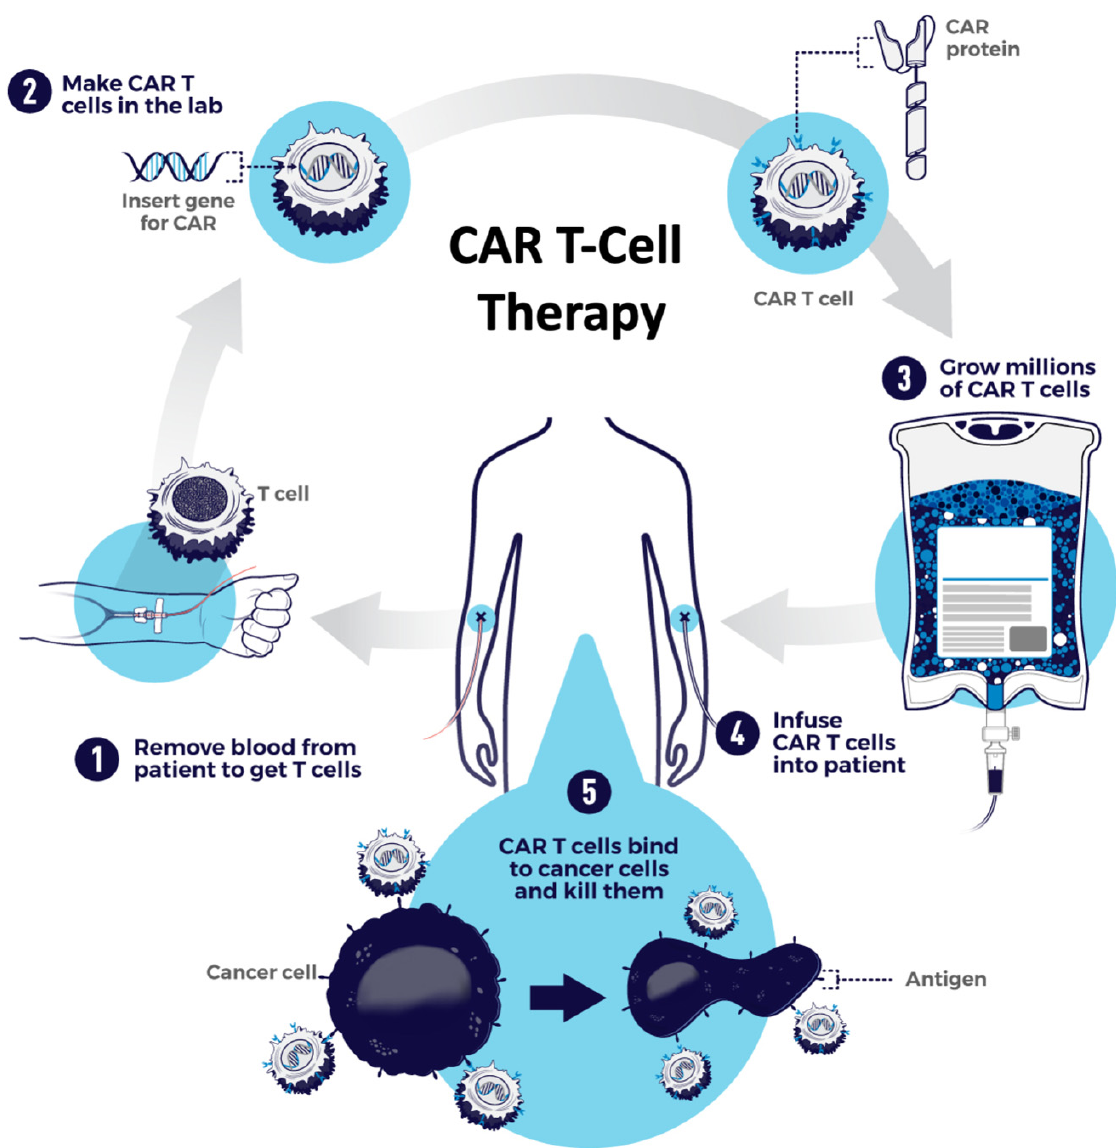
Figure 1. The general manufacturing process of CAR-T cells, involving (1) leukapheresis, (2) transportation of T-cells to a GMP facility where they are genetically modified and transduced with the CAR, (3) are expanded, purified and undergo quality checks, (4) then are transported back to the treating facility where the patient is treated with lymphodepleting chemotherapy and then infused with the CAR-Ts, (5) which then engage with cancer cells by recognition of the target antigen to mediate the therapeutic effect. Credit: NIH-NCI, open source image.